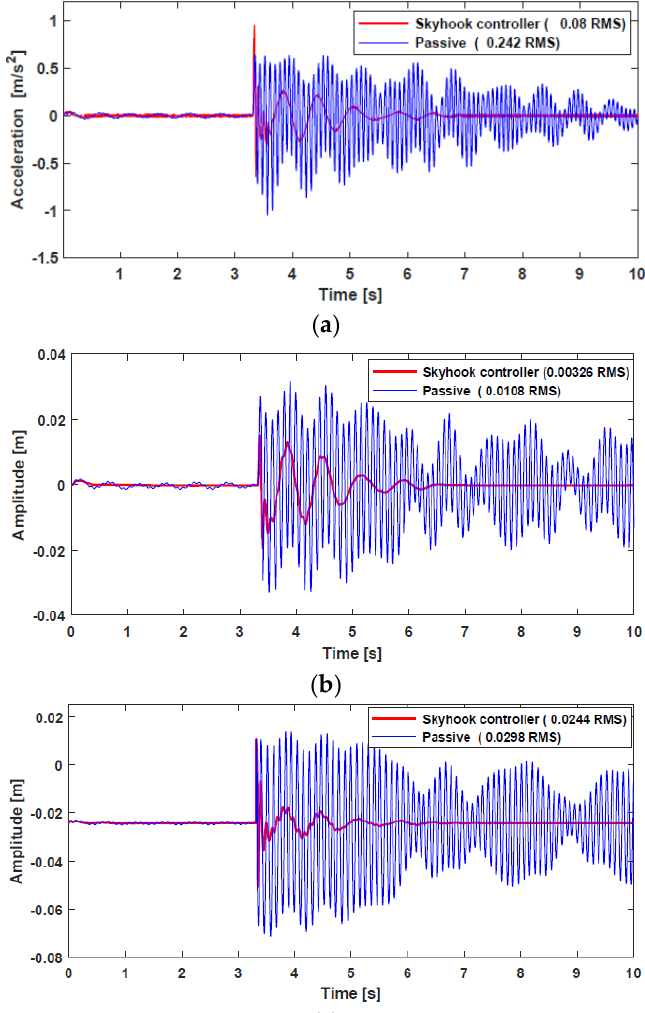
Figure 13. Time responses for a normal vehicle under bump road excitation: ( a ) vertical acceleration from the center of gravity; ( b ) suspension deflection; ( c ) tire deflection.